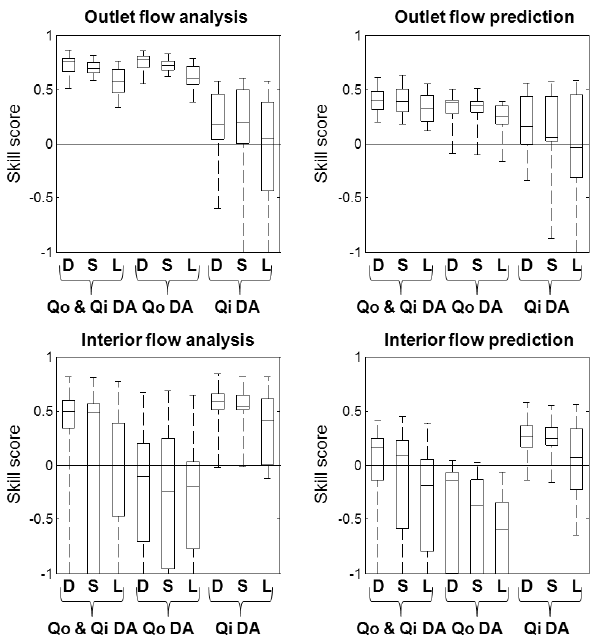
Fig. 8. Same as Fig. 7, but for the temporal adjustment scale. Here 1, 6, and W denote adjusting mean field bias in the precipitation and potential evaporation data on an 1-h or 6-h basis, or uniformly over the entire assimilation window, respectively.